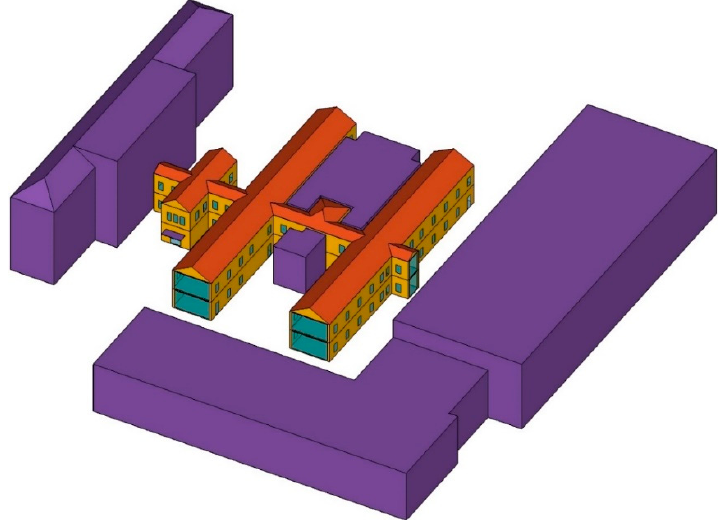
Figure 4. TRNSYS 3D model of the Building 8, Politecnico di Milano—Lecco Campus. All the volumes near the building are represented in purple: They have not been identified as thermal zones but as simple shading bodies. The parts in blue are the windows, the ones in yellow are the external walls, and the red ones represent the roof.